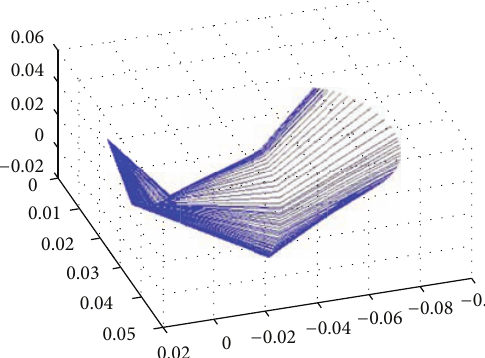
Figure 31: Motion due to glenohumeral joint and elbow joint movement in horizontal